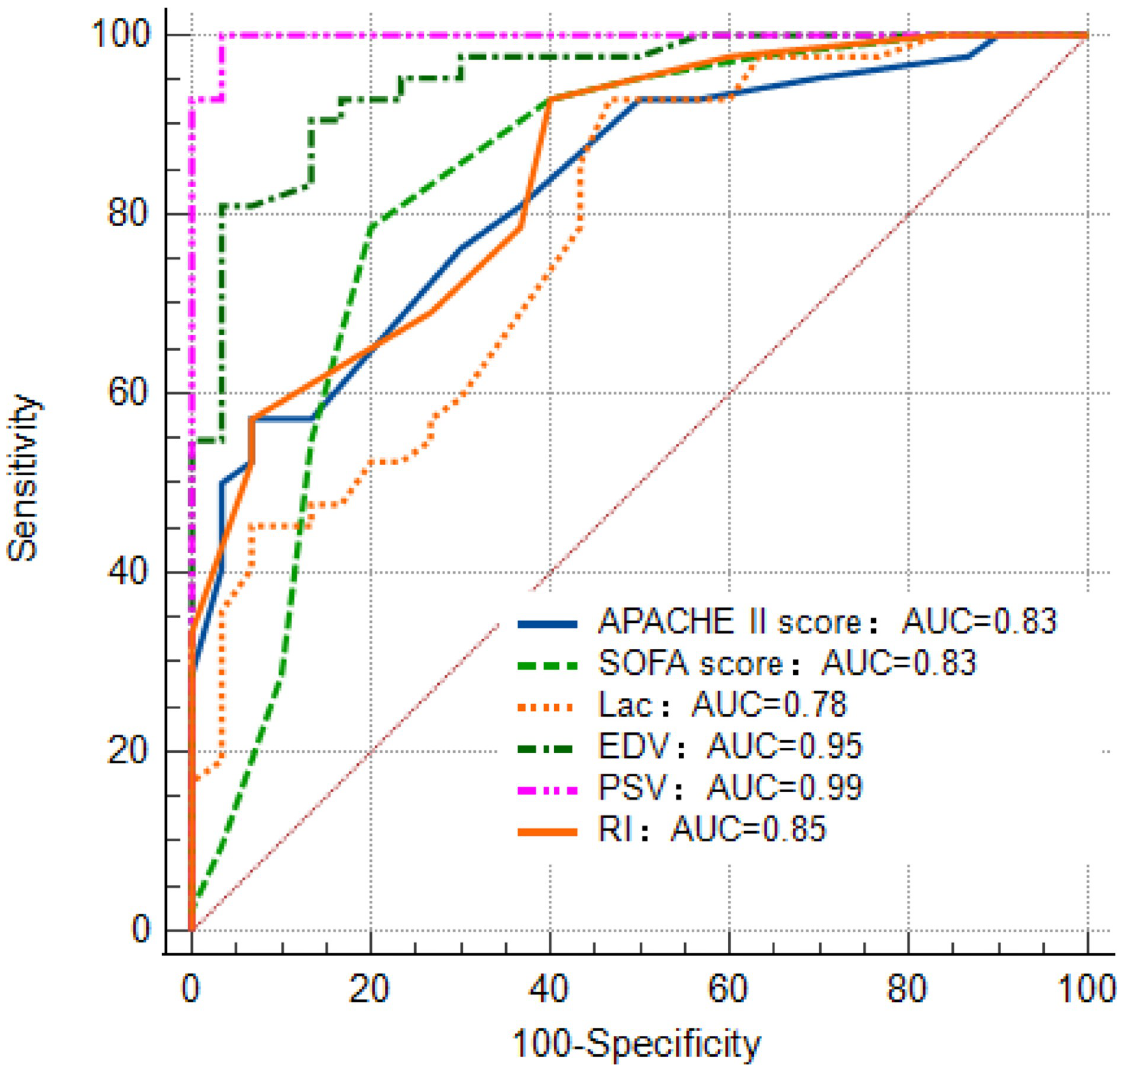
Fig 1. The area under the receiver operating characteristic (ROC) curve (AUC). (APACHE II: Acute Physiology and Chronic Health Evaluation II; SOFA: Sepsis-related Organ Failure Assessment; Lac: Lactate; PSV: Peak systolic velocity; EDV: End-diastolic velocity; RI: Resistive